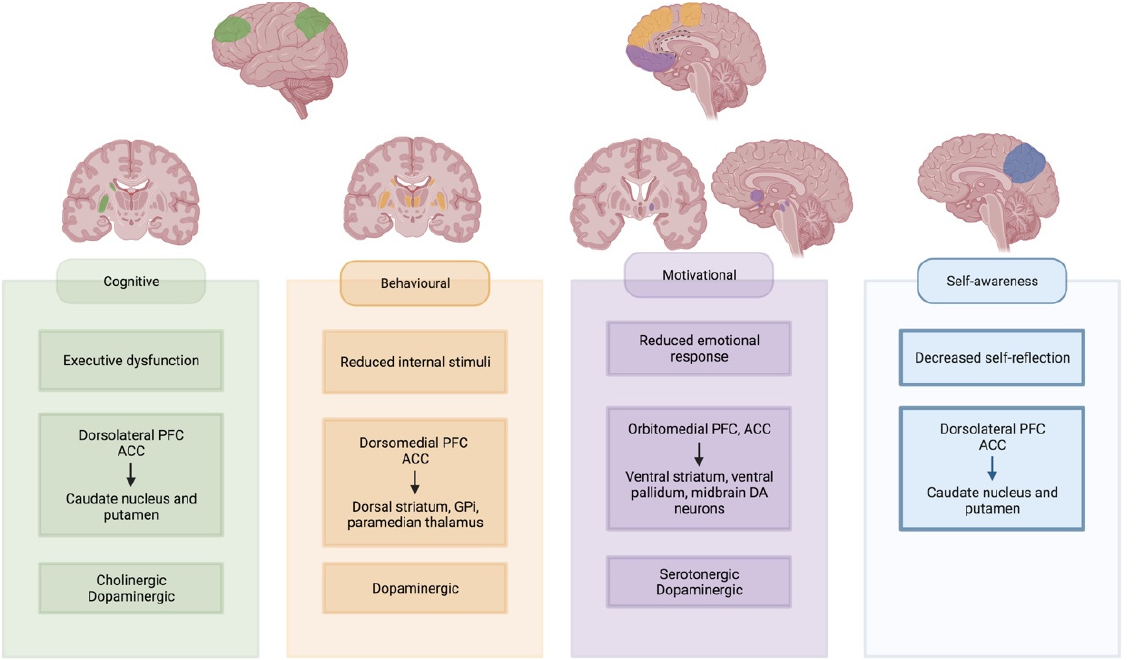
Figure 2. Neural networks underlying apathy subtypes. Involved cortical regions and basal ganglia regions are highlighted for each subtype. Created with https://biorender.com/ (accessed on 27 June 2022). Abbreviations: PFC: prefrontal cortex; ACC: anterior cingulate cortex; Gpi: internal globus pallidus; DA: dopaminergic.